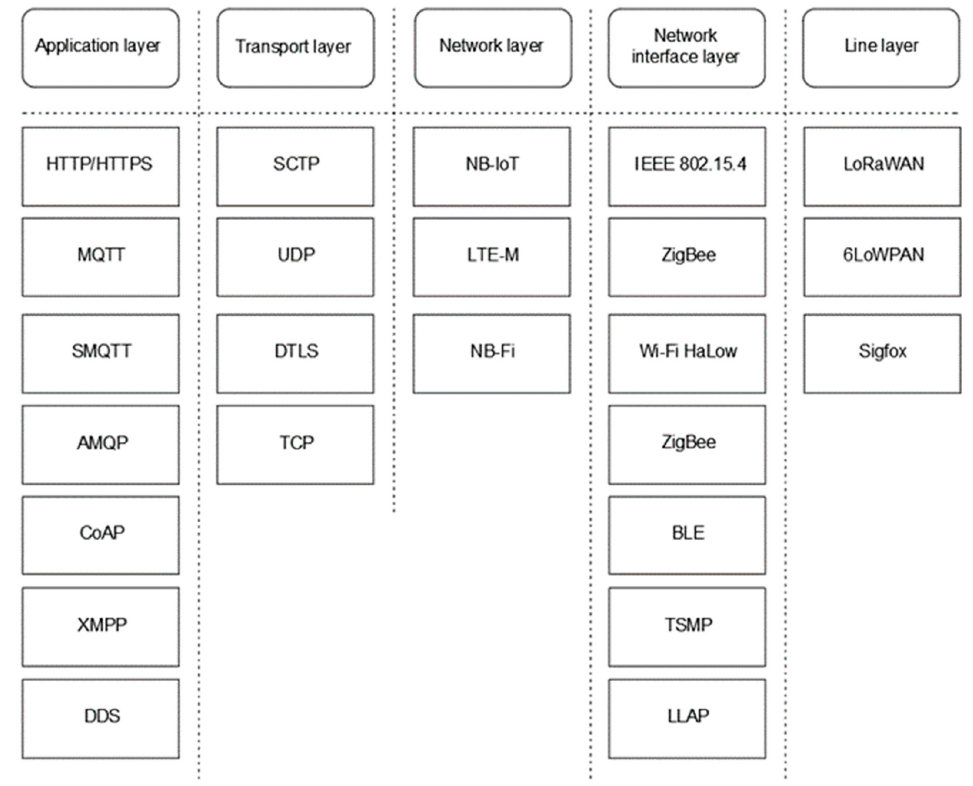
Figure 8. IoT protocols and standards.